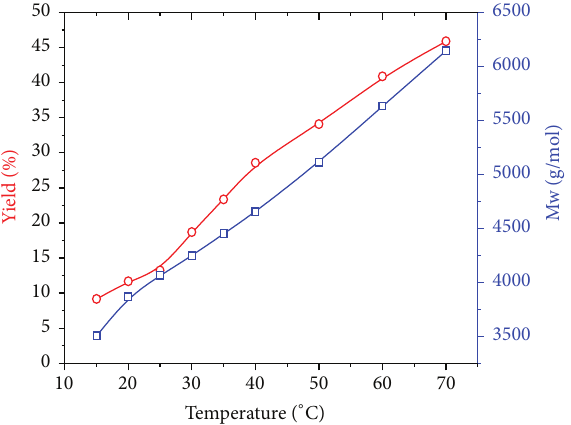
Figure 4: Yield and Mw of PCHO as a function of reaction tem- perature. Polymerization catalyzed by 0.2 g of H 3 PW 12 O 40 during 3 hours in CH 2 Cl 2 .